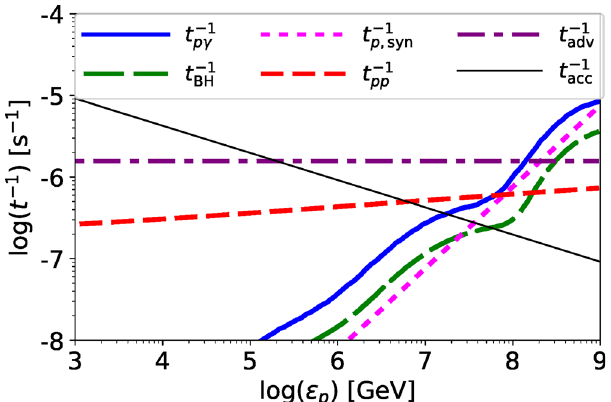
Fig. 7 Acceleration and energy loss rates as a function of the proton energy for NGC 4579. The thick-solid, thick-long-dashed, thick-dotted, thick-short-dashed, and thick-dotted-dashed lines are energy loss rates by photomeson production, Bethe-Heitler, synchrotron, pp inelastic collision, and infall processes, respectively. The thin-dotted line indicates the acceleration rate. We use M = 7.2 × 10 7 M ⊙ and _ m ¼ 8 : 0 ´ 10 (cid:3) 3 with a parameter set for model A (reference model: see Table